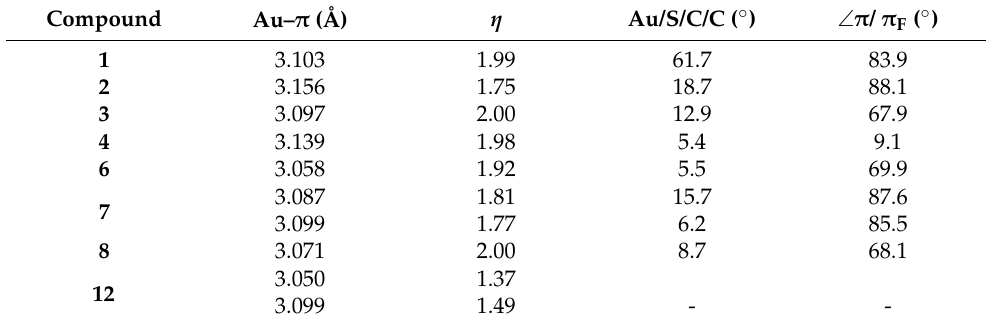
Table 2. Structural parameters determined from the crystal structures of the fluorothiolate derivatives. Compound Au– π (Å) η Au/S/C/C ( ◦ ) ∠ π / π F ( ◦